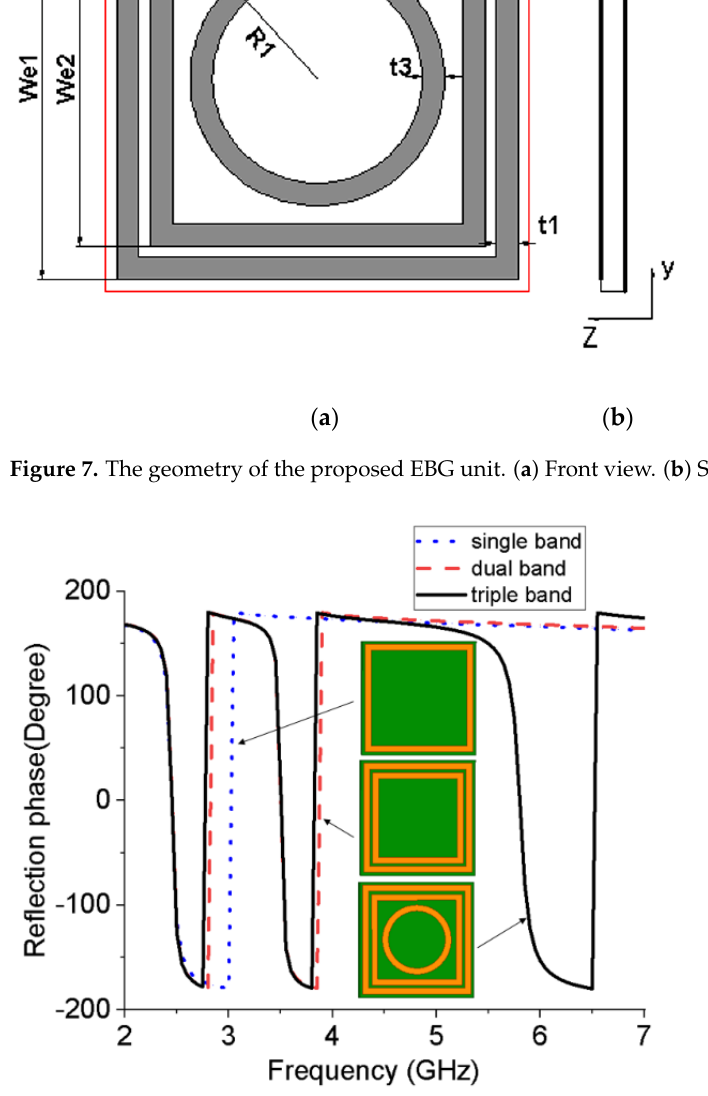
Figure 8. Reflection phase of the proposed triple-band EBG unit compared with the single-band and dual-band EBG.